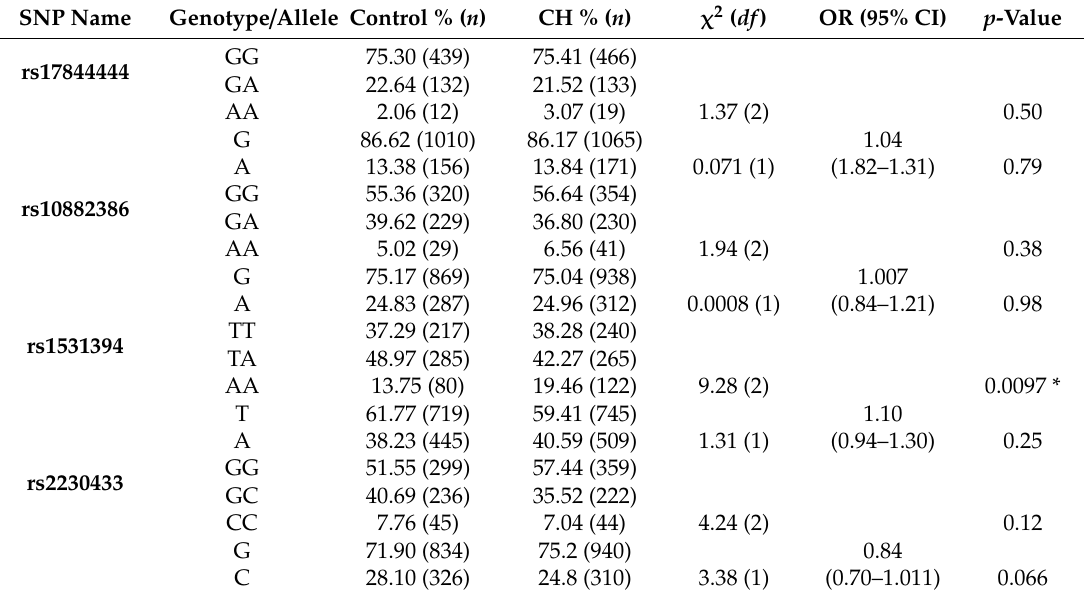
Table 4. Statistical analysis of genotypes and alleles.